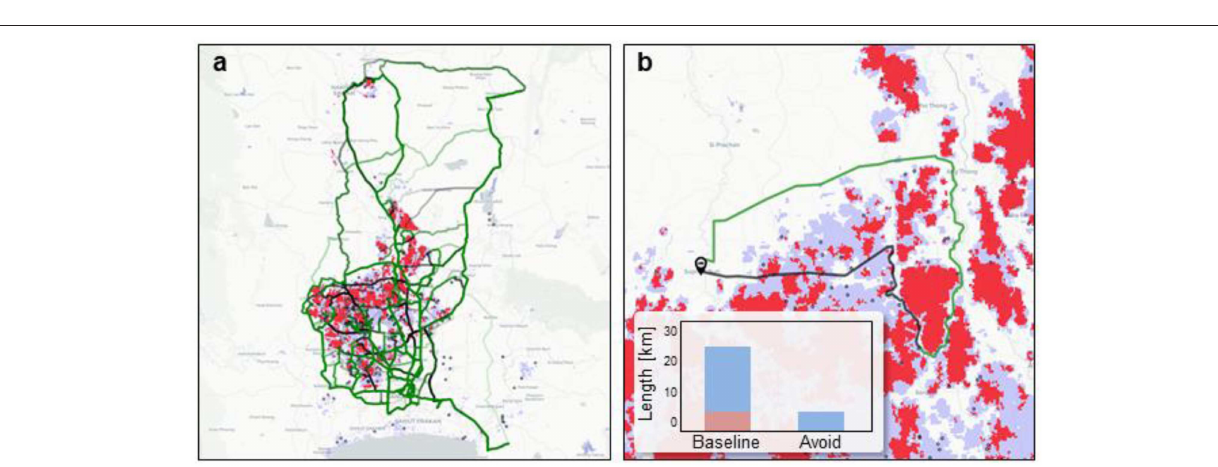
potentially be used to inform a disaster management